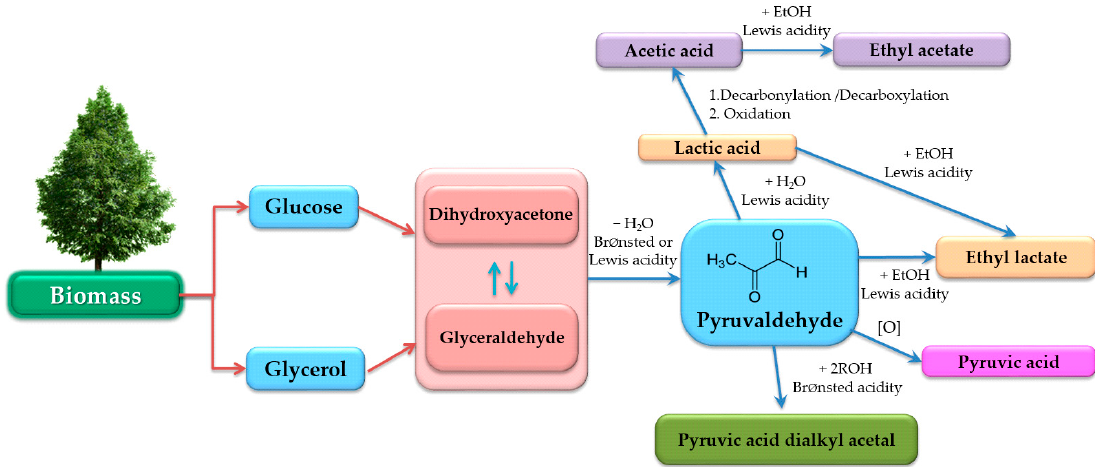
Figure 1. Scheme of the reaction pathways of biomass into DHA, glycerol, and pyruvaldehyde and its further derivatives. The conversion of DHA obtained from biomass to LA and other compounds is of particular interest. The isomerization of DHA in an aqueous medium enables the pro- duction of lactic acid and its derivatives. The reaction proceeds to form methylglyoxal by the dehydration of the triose. This is followed by an intra-molecular Cannizzaro-type rearrangement reaction with hydrogen transfer (Figure 2) [8].